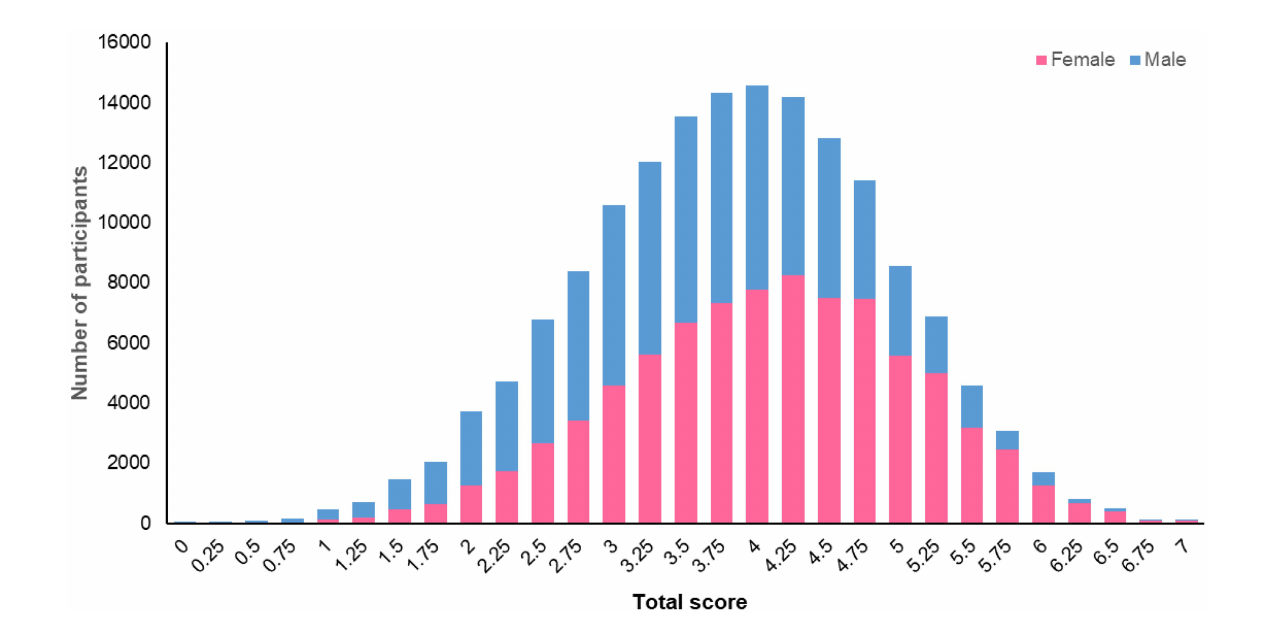
FIGURE 1 Distribution of total adherence scores for male and female UK Biobank